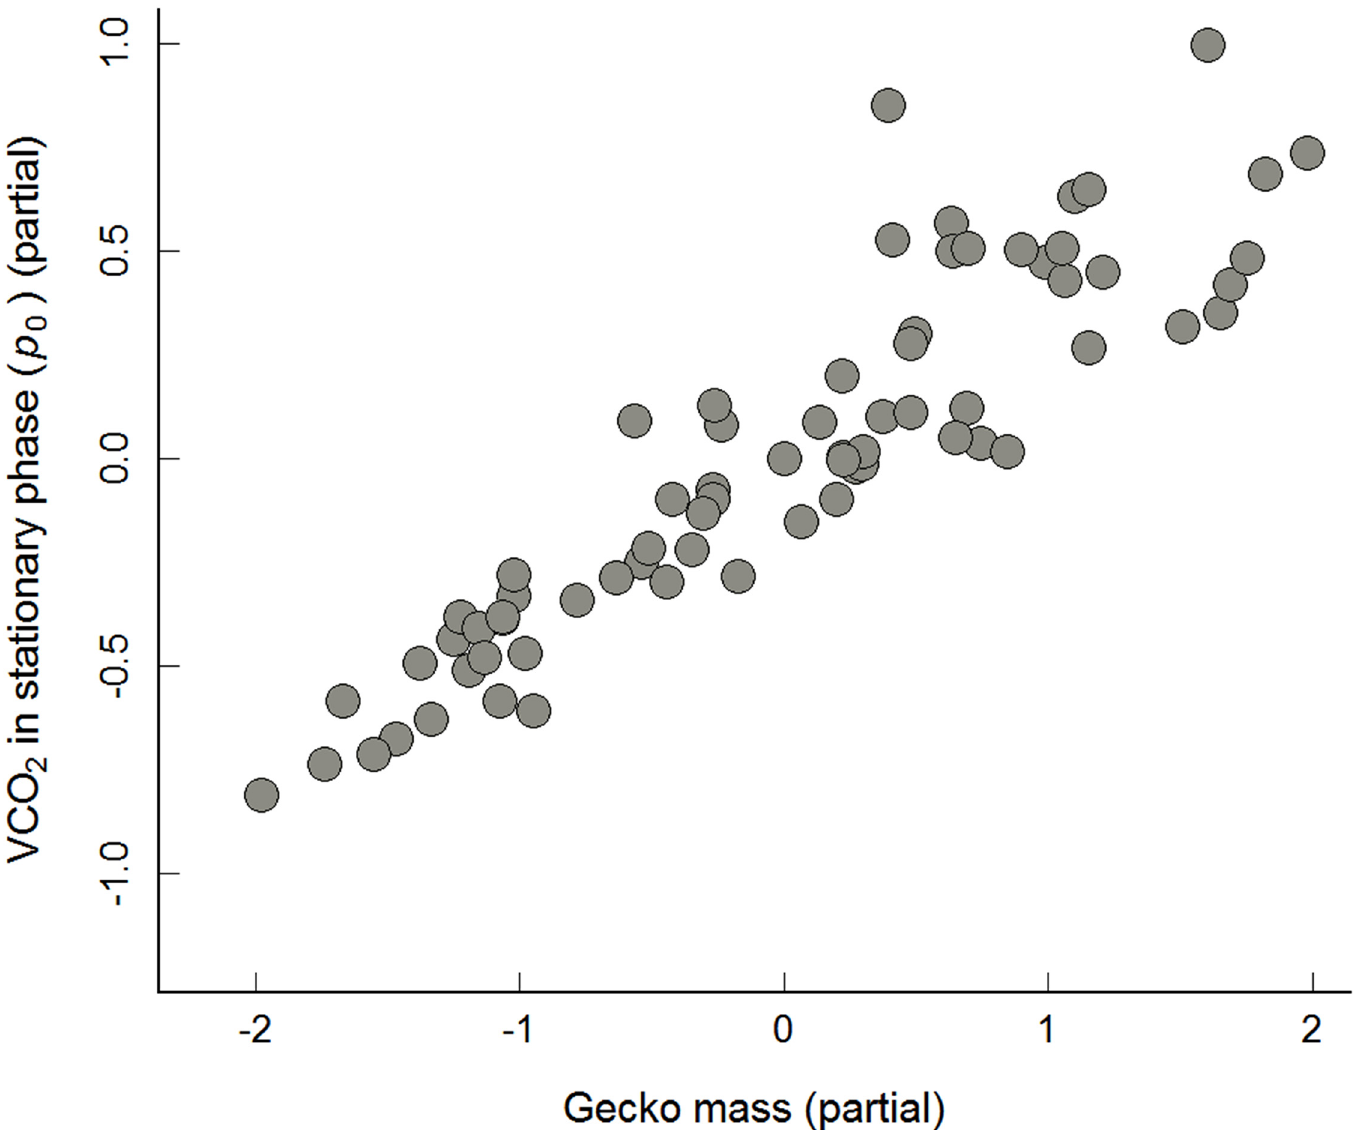
Fig 2. Relationship between mass versus VCO 2 production in stationary phase ( p 0 ) for recently active geckos. Partial regression plot ( y axis: residuals of regressing the response variable on the explanatory variables, but omitting the explanatory variable of interest, and x axis: residuals of each explanatory variable of interest regressed on all remaining explanatory variables) of the relationship of gecko mass to VCO 2 produced in stationary phase ( p 0 ) for recently active geckos ( n = 70) given the effect of population. Minimal regression model for recently active geckos: VCO 2 ( p 0 ) = (0.390 × gecko mass) – 0.101; model adjusted R 2 =